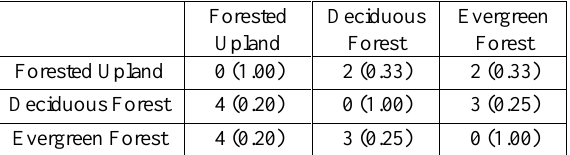
Table 5 Semantic Distance (Semantic Similarity) in the Transformational Model